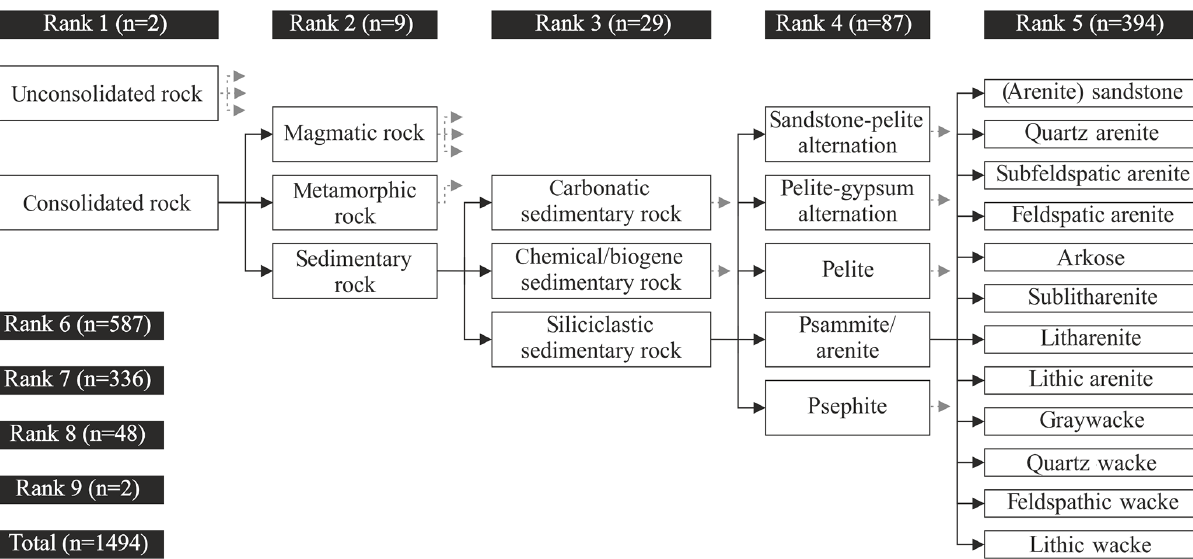
Figure 3. Hierarchical system of standardised petrographic terms used for the database. White boxes are sample chosen extracts to illustrate the structure of the petrography classification. Black boxes document the number of rock type categories per rank for the entire classification scheme. These interconnected standardised terms allow for the connection of certain lithologies/petrographies to specific petrophysical properties and are thus the basis for statistical analysis. Black arrows show direct connections, while grey arrows indicate that there are additional terms not displayed